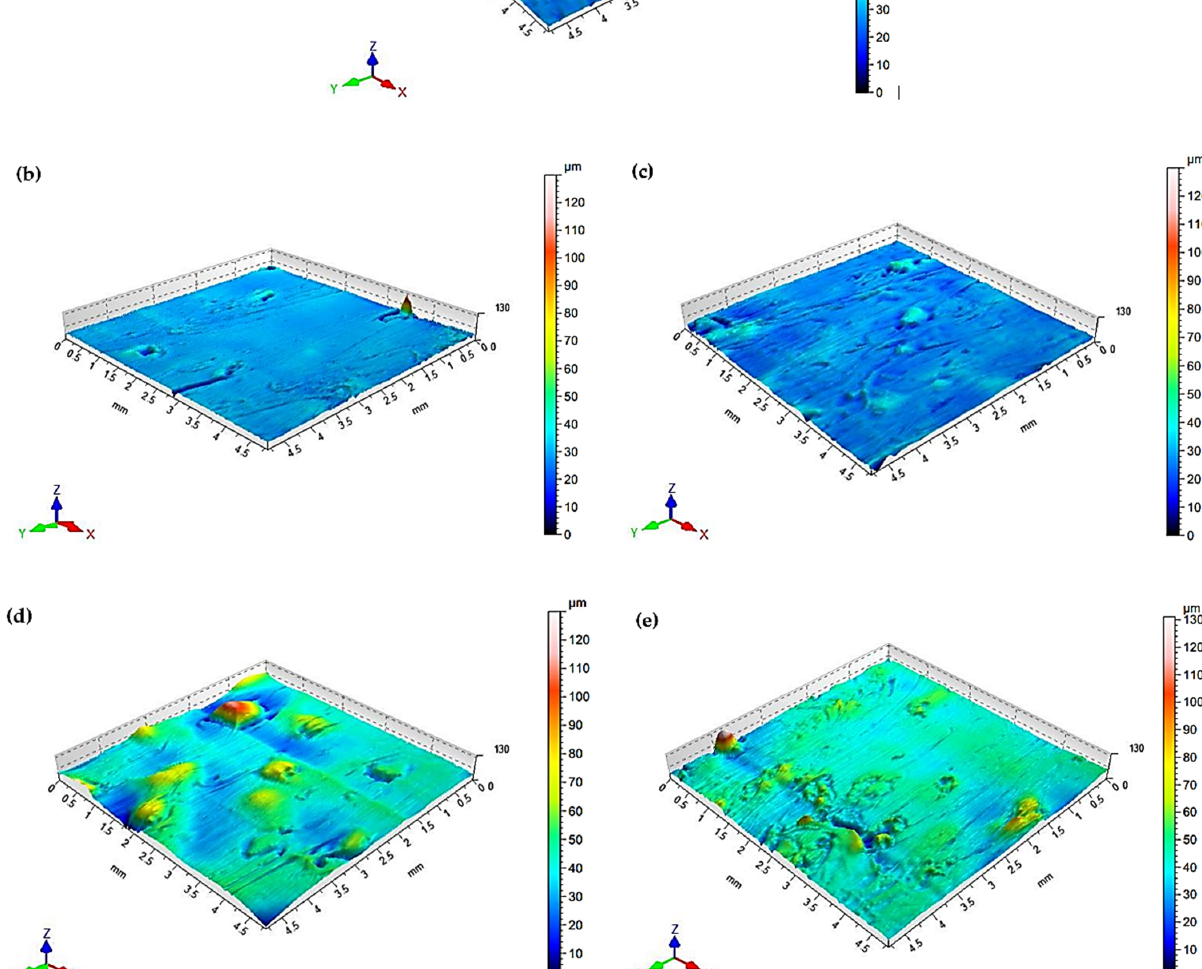
Figure 8. Surface topography of polymer composite samples containing 20 wt% natural filler, i.e., pumpkin seed hulls with grain sizes of 0.6–0.8 mm (the samples are shown before and after the solvent immersion); ( a ) reference sample, ( b ) distilled water, ( c ) NaOH solution, ( d ) acetone, ( e )